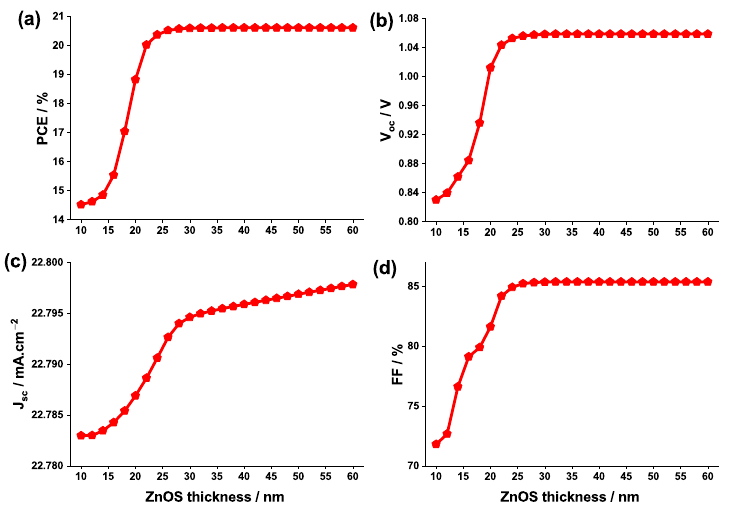
Figure 10. Change in ( a ) PCE, ( b ) V oc , ( c ) J sc , ( d ) and FF as function of the ETL ZnOS